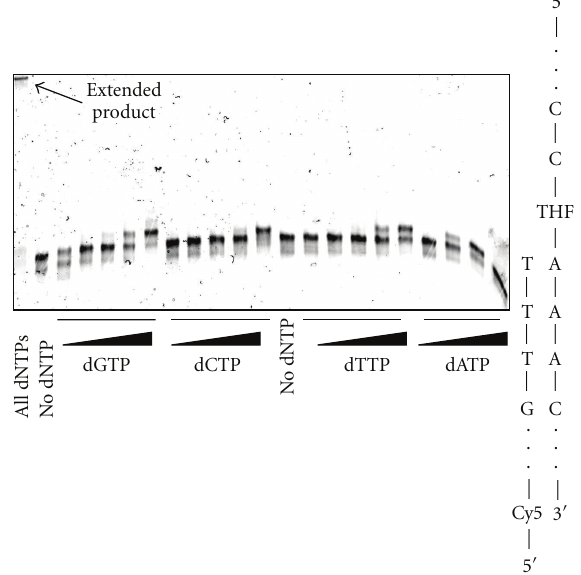
Figure 11: Preferential insertion of the individual dNTPs opposite a THF abasic site located on the 5 (cid:2) -terminus (A-27) of an A 4 tract by T7 Sequenase. The dNTP concentrations used were 0.005, 0.5, 5, 50 and 500 μ M (for dATP the 500 μ M concentration is not shown). Lanes with no added dNTP and with all dNTPs are included. dATP and dGTP are most e ffi ciently inserted opposite the THF